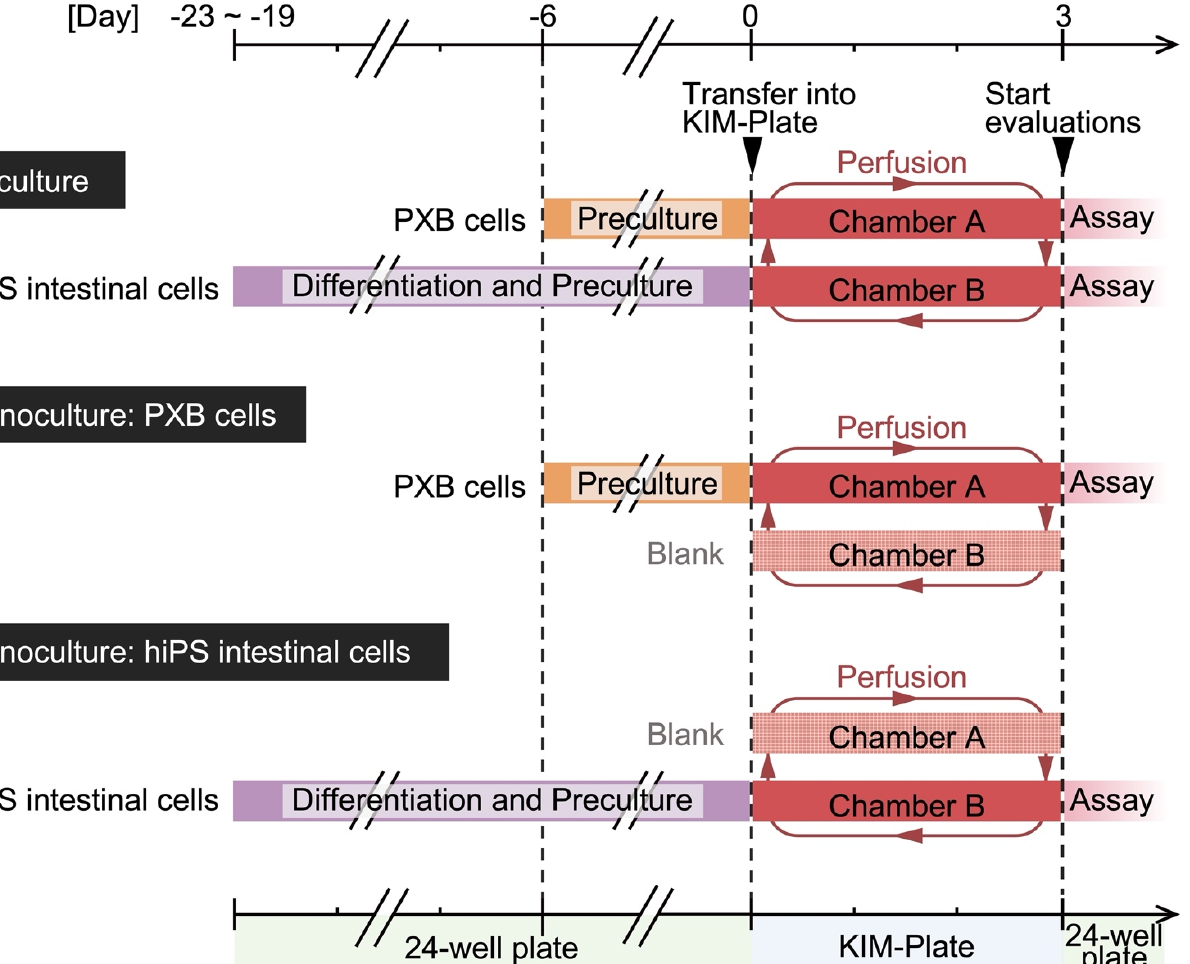
Figure 2. Experimental schedule for coculture and monoculture using the kinetic pump integrated microfluidic plate (KIM-Plate). Cells were seeded onto cell culture inserts or cell desks. Cell differentiation, preculture, and functional evaluation were performed in conventional 24-well plates, and cells on the culture inserts and cell desks were introduced into the KIM-Plate only during perfusion culture.